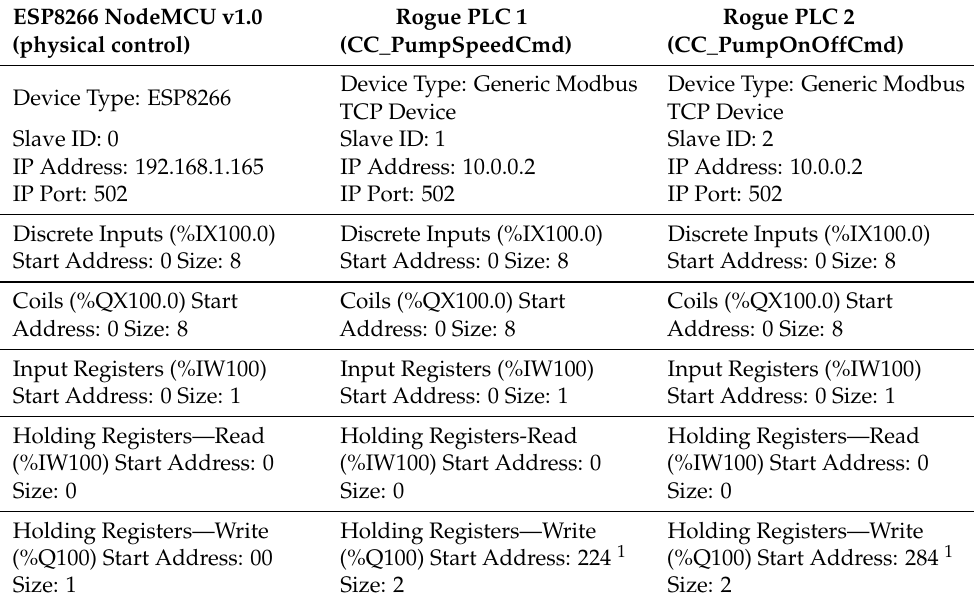
Figure 14. ESP8266 NodeMCU v1.0 OpenPLC address mapping. Table 5. OpenPLC slave configuration